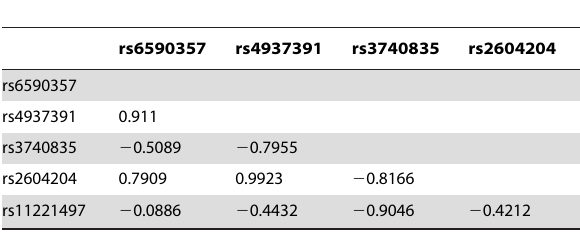
Values shown represent D 9 .